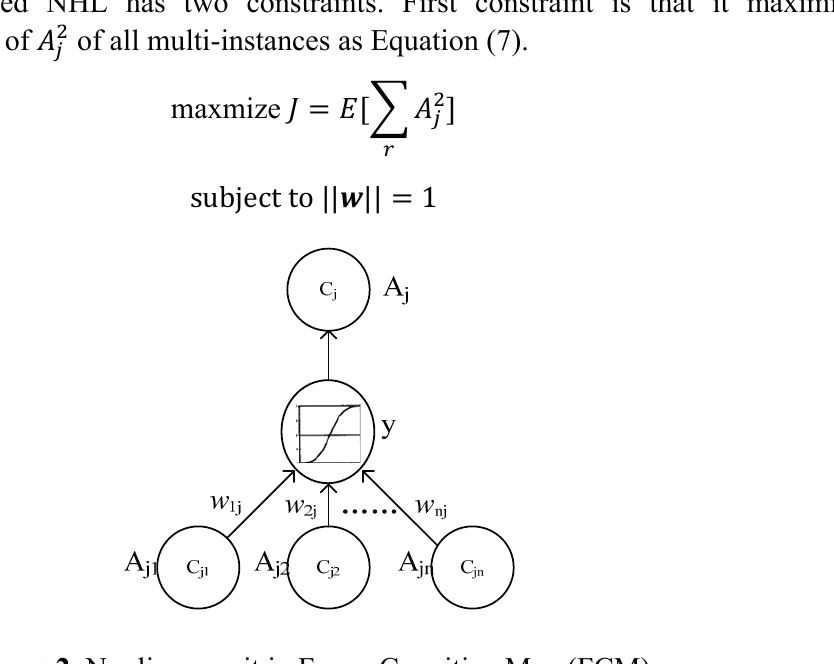
Figure 2. Nonlinear unit in Fuzzy Cognitive Map